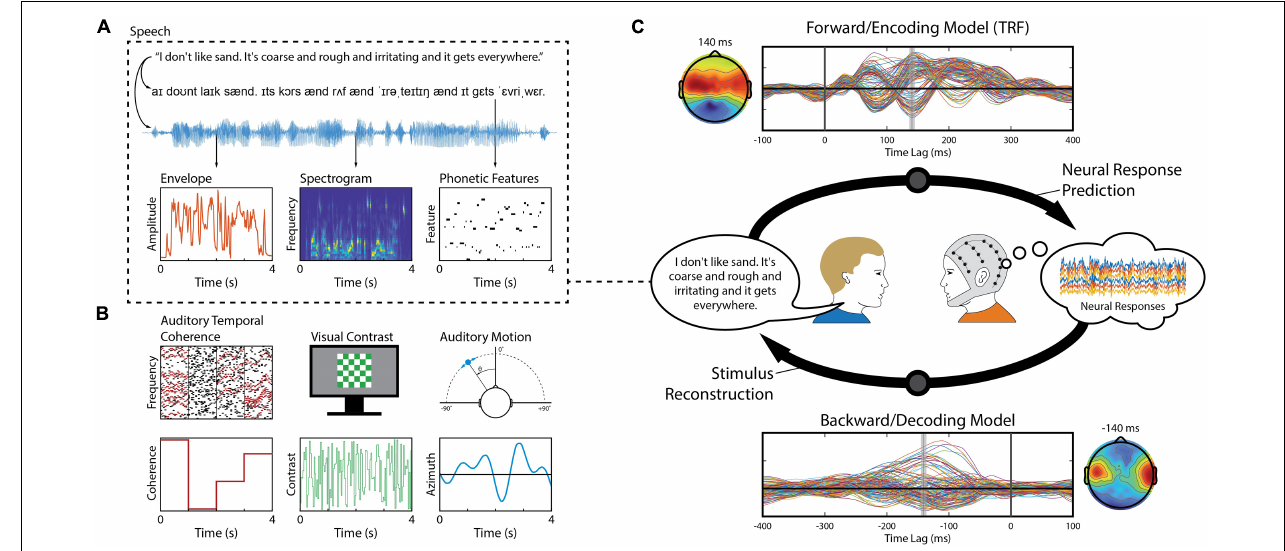
FIGURE 1 | Stimulus features and linear modeling framework. (A) A speech signal contains both acoustic and linguistic information and thus can be represented by several different features, such as the envelope, spectrogram, and the timing of phonetic features. Each of these features (or combinations of them) can be used to construct linear models that relate them to the neural activity. (B) Aside from speech, linear modeling can be used to quantify responses reflecting, for example, perceptual object formation (O’Sullivan et al., 2015b), visual contrast modulation (Lalor et al., 2006), and auditory motion (Bednar and Lalor, 2018). (C) In a series of experiment trials, an observer (right) is presented a stimulus – here, a speaker (left) produces a speech signal (blue time-series shown in panel A ) – while EEG is recorded simultaneously from their scalp (multi-colored time-series shown in the thought cloud). We can extract any of several features from that stimulus, such as the envelope (red trace in panel A ). Forward modeling (top arrow) fits a set of weights in an attempt to predict EEG data from a set of stimulus features. Those weights, known as a Temporal Response Function (TRF), are biologically interpretable, akin to a conventional Event Related Potential (ERP). Conversely, backward modeling (bottom arrow) fits a set of weights that map in the reverse direction, known as a decoder, in order to reconstruct a set of stimulus features from the EEG data. While these coefficients are informative, they are not neurophysiologically interpretable in the same way as a TRF.